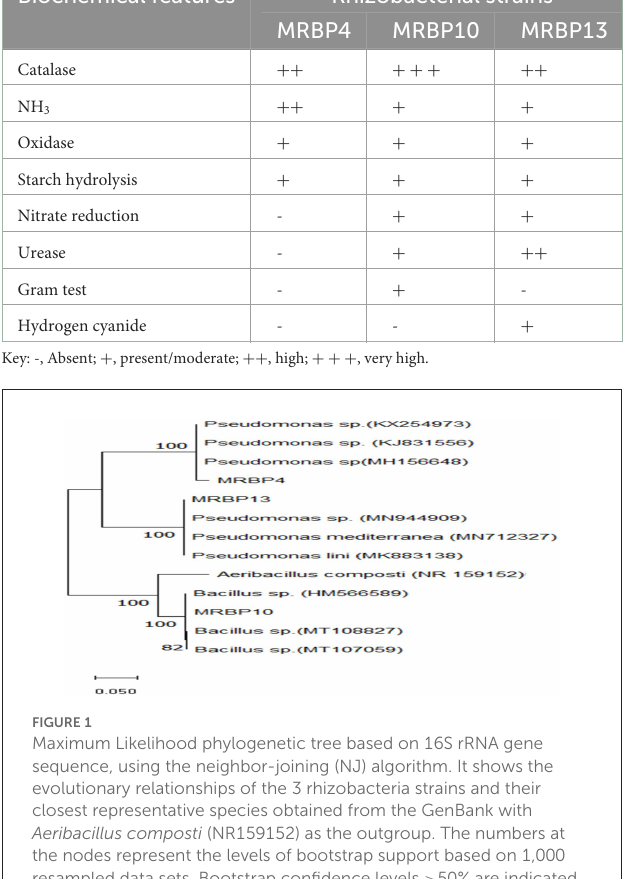
MRBP10 (0.87 ± 0.03 mm) but was not significantly different from EPS production by Pseudomonas sp. MRBP4 and Pseudomonas